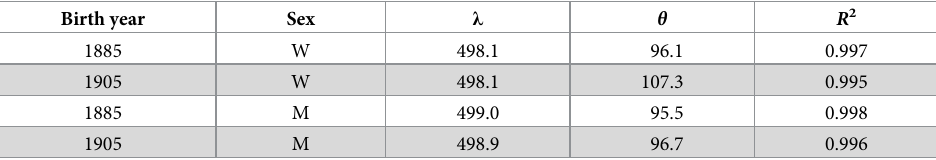
Table 1. Parameters of the models that best fit the data. The value of the other parameters were held fixed at: μ 0 = 550, β = 0.485/365. The R 2 column shows the R 2 value calculated over the age range 55 to 99.